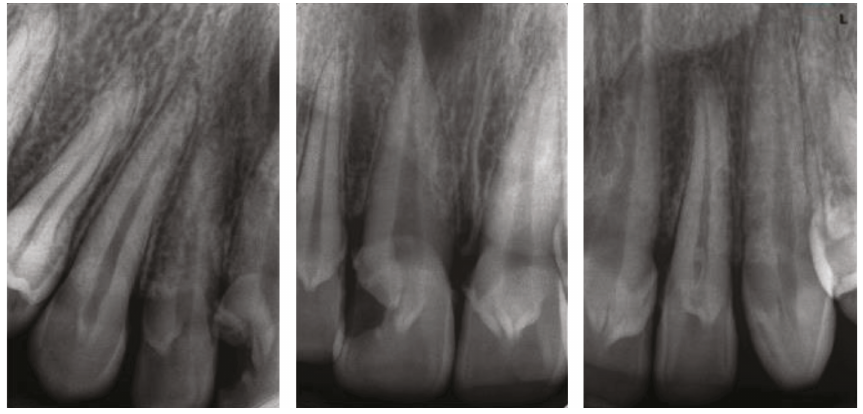
Figure 8: Case 2: periapical radiograph shows radiographic appearance of talon cusp.